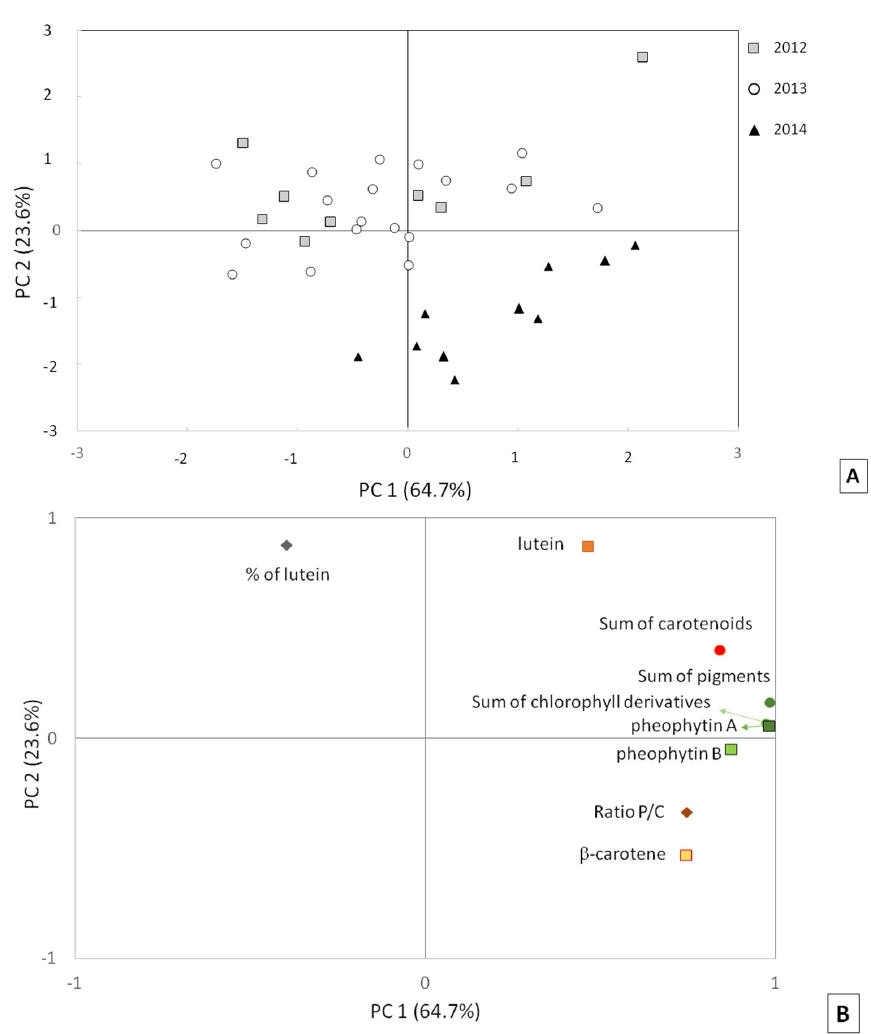
Figure 5. Results of the multivariate analysis. ( A ) Score plot of the principal component analysis (PCA) modelling, showing the EVOO samples harvested in 2012 ( (cid:4) ), 2013 ( of the PCA modelling, showing the variables used for the analysis. P/C: ratio between total amount of chlorophyll derivatives and the total amount of